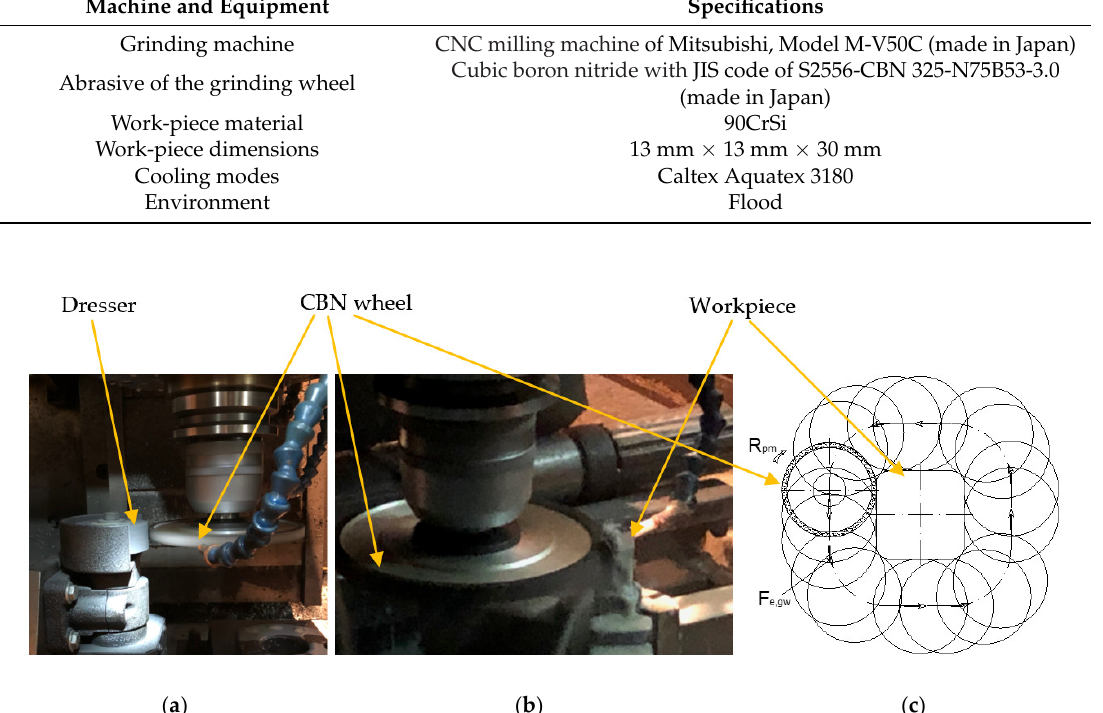
Figure 1. Experimental setup. ( a ) Dressing setup; ( b ) grinding setup; ( c ) grinding schema.